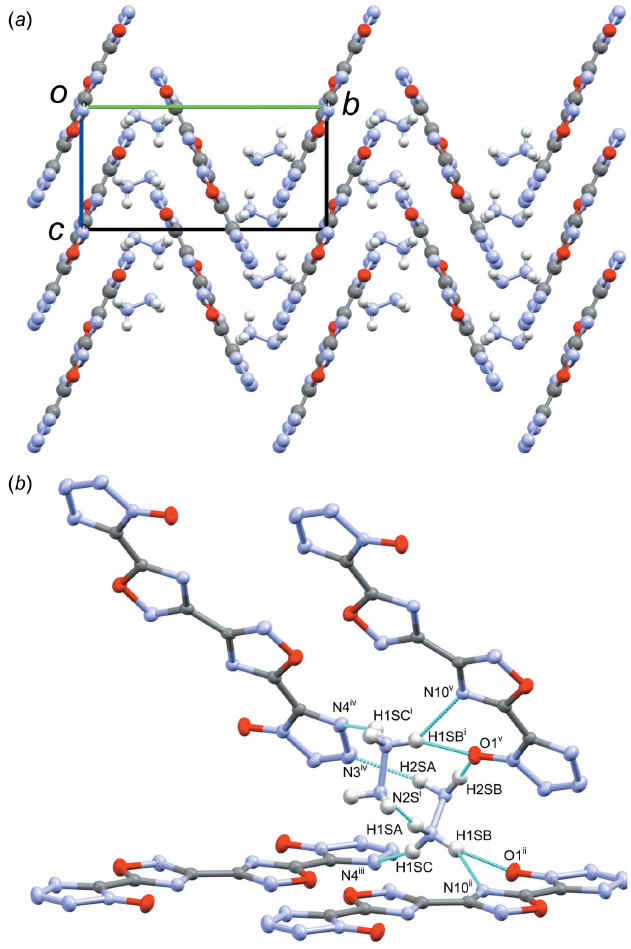
Figure 6 ( a ) Wavelike packing of 1 as seen down the a -axis, showing the opposing columns of the dianion with hydrazinium occupying gaps between the columns, and ( b ) view highlighting the hydrogen-bonding network (intermolecular contacts) between the dianions and hydrazinium cations, and between the two hydrazinium cations. [Symmetry codes: (i) x , (cid:3) y + 5 z + 1 ; (ii) (cid:3) x + 2, (cid:3) y + 2, (cid:3) z + 1; (iii) (cid:3) x + 1, (cid:3) y + 2, (cid:3) z + 1; (iv) (cid:3) x + 1, 2 y +